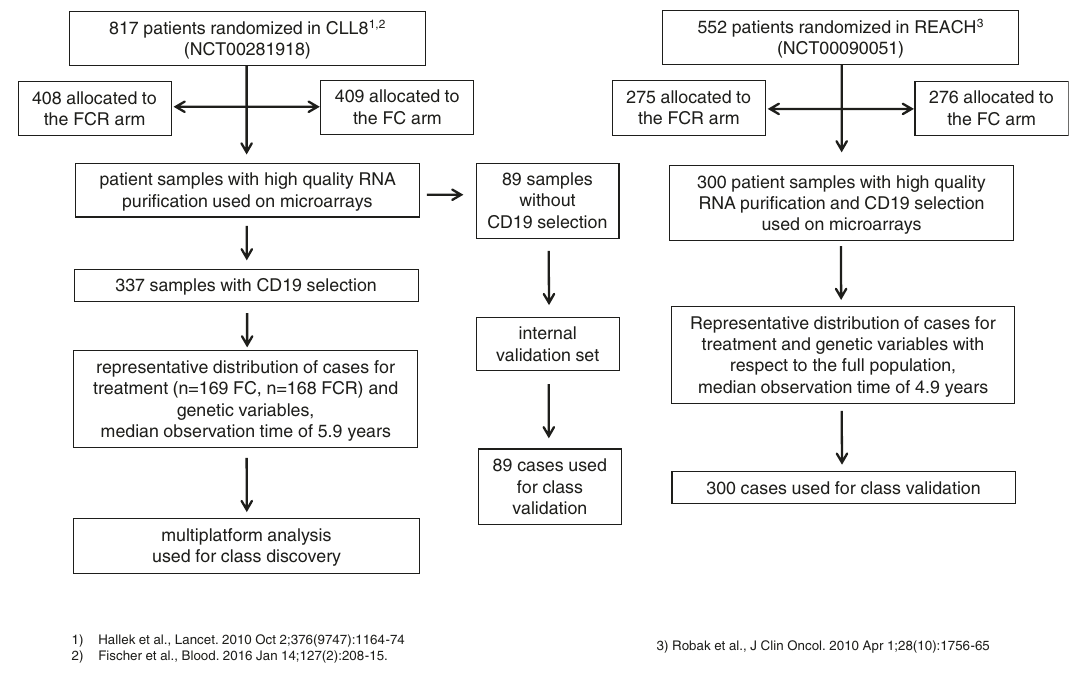
Fig. 7 CONSORT diagram for the discovery and validation cohort. CONSORT diagram providing information on enrollment and randomization for the CLL8 and REACH trial, along with details on the selection process of patient specimens used for class discovery and validation by gene expression pro fi